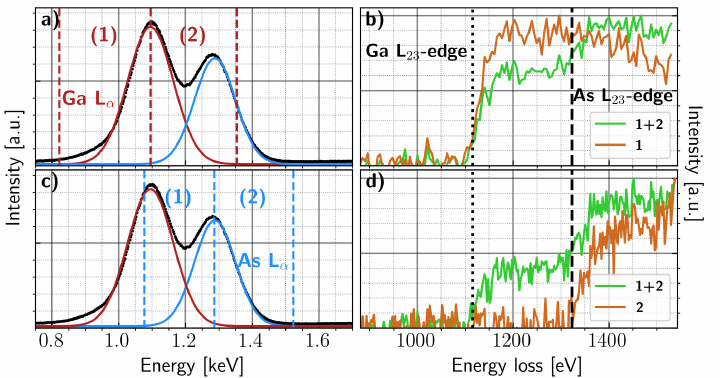
Figure 4. ( a ) The EDX spectrum of GaAs where the Ga peak is fitted with a Gaussian to indicate the extent of the X-rays originating from the de-excitation of the Ga atom. The red and blue line indicate the extent of the X-ray lines in the energy spectrum. ( b ) The background-subtracted EEL spectra using the X-rays in the regions are indicated by the legend. When only using X-rays from region 1 , it is seen that only the Ga L 23 edge is selected without the As L 23 edge (brown). When regions 1+2 are selected, electrons from both edges are seen (green). ( c ) The same as (a) where the X-ray regions, out which the coincidence events are chosen, have been modified. ( d ) The background-free EEL spectrum where, by selecting the proper X-ray window ( region 2 ), only the As L 23 edge is selected (brown). When regions 1+2 are selected, electrons from both edges are seen (green).